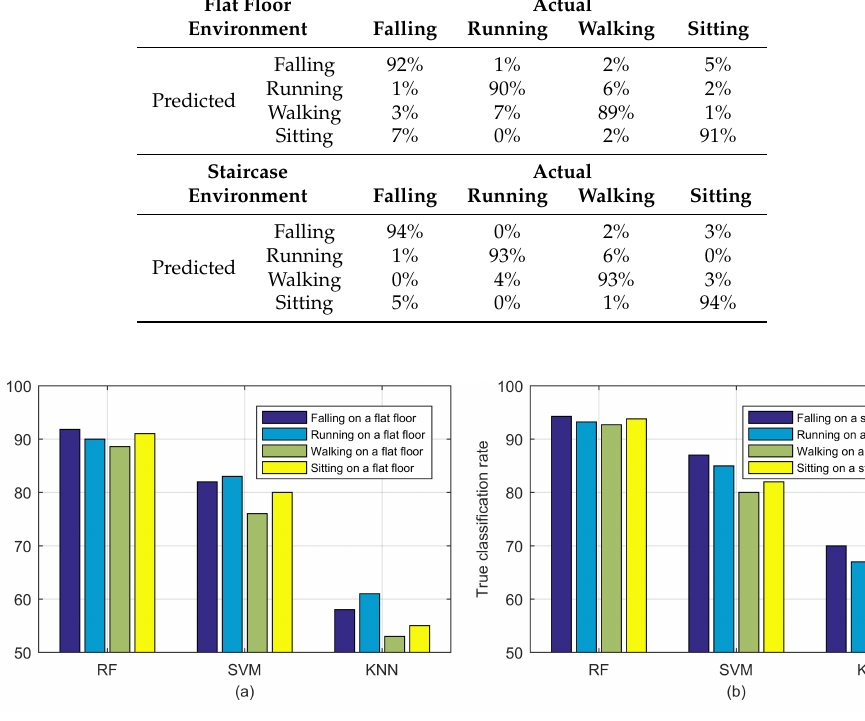
Figure 12. Fall detection results: ( a ) flat floor environment; ( b ) staircase